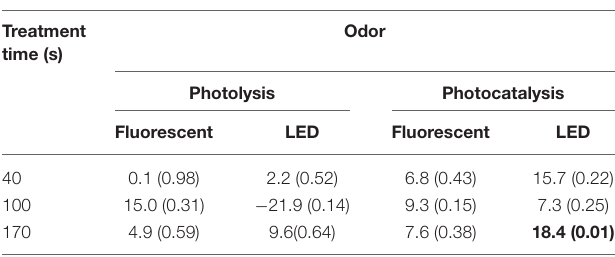
TABLE 7 | Mitigation of ozone concentration (ppb).